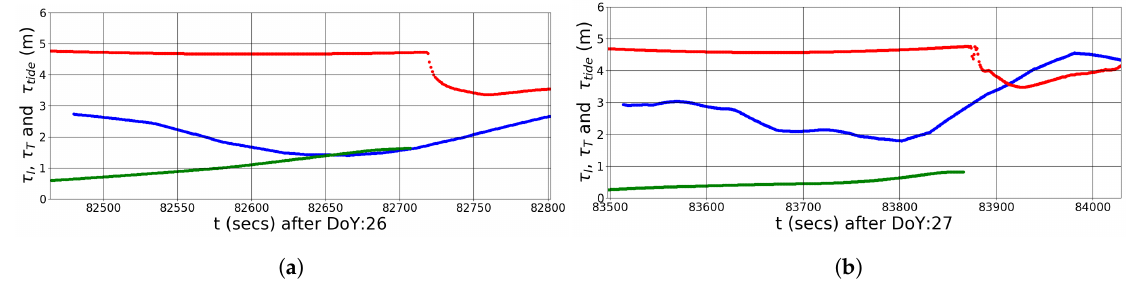
Figure 3. The modeled delays due to tidal τ tides (green), ionospheric τ I (blue) and tropospheric effects τ T (red), are represented for the two transects. ( a ) 26 January 2015. ( b ) 27 January